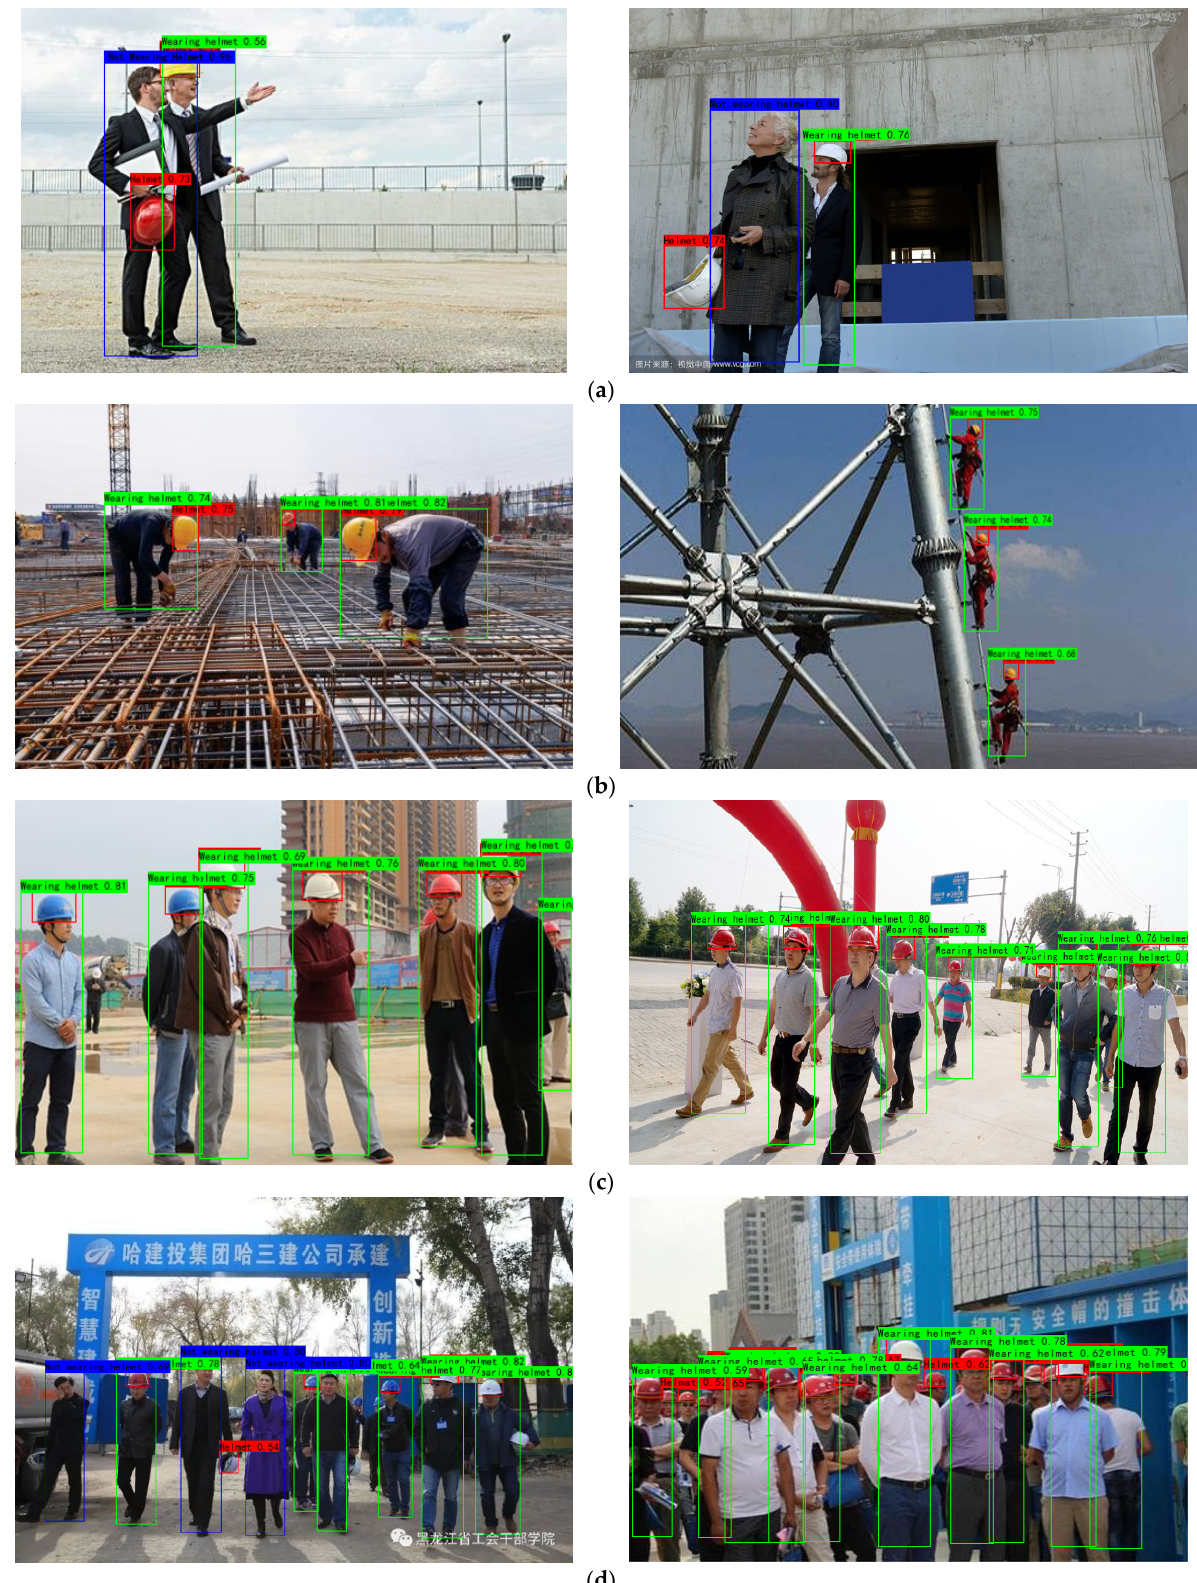
Figure 5. ( a ) Hand-held helmet prone to wrong inspection, ( b ) long-range small target phenomenon, ( c ) severe obstruction problem, ( d ) crowding